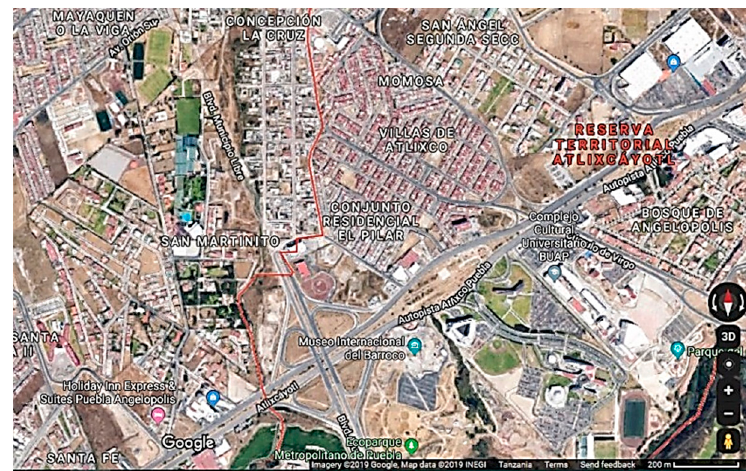
Figure 8. Middle class housing in Atlixcáyotl. Source: Google Maps (accessed 23 July 2019). Land use: Urban, commercial services, Middle-class and social housing; Tenure System: Expropriated ejido for urban development; Stakeholders: Ejidatarios , Regional authorities, Regularization agency (Institute for Sustainable Land), Private developers.